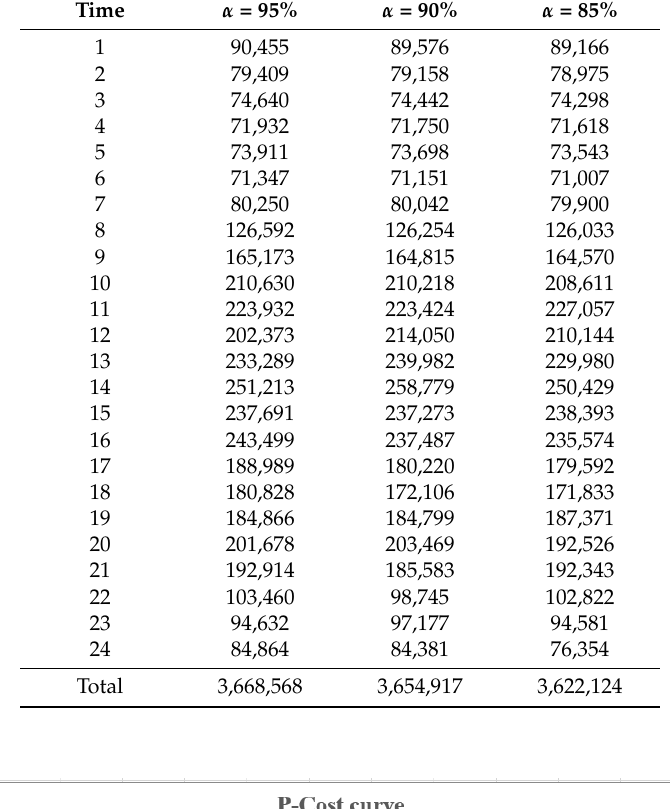
Table 2. VAR at the various confidence levels.